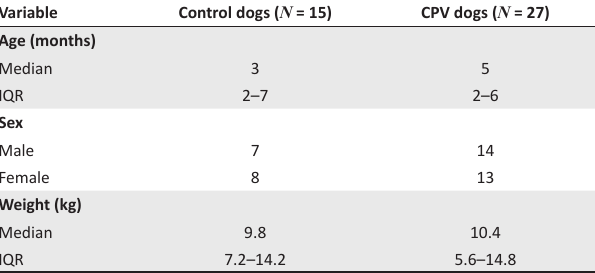
TABLE 1: Signalment of dogs included in the canine parvovirus group and control group.